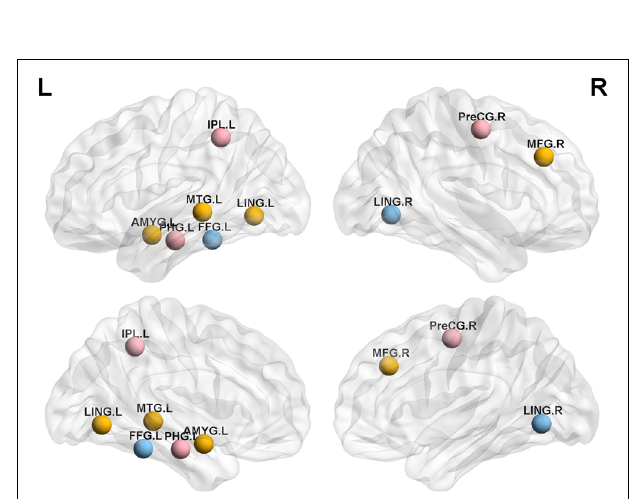
FIGURE 4 | Nodal centrality of brain network. Results showed significantly different regions in the nodal centrality between APOE 4 − T − and the following groups: APOE 4+T+ (orange nodes), APOE 4+T − (pink nodes), APOE 4 − T+ (blue nodes), after 5,000 permutation testing ( p < 0.05, FDR-corrected). Abbreviation: IPL.L, left inferior parietal, but supramarginal and angula gyri; PHG.L, left parahippocampal gyrus; LING.L, left lingual gyrus; MTG.L, left middle temporal gyrus; AMYG.L, left amygdala; FFG.L, left fusiform gyrus; PreCG.R, right precentral gyrus; MFG.R, right Middle frontal